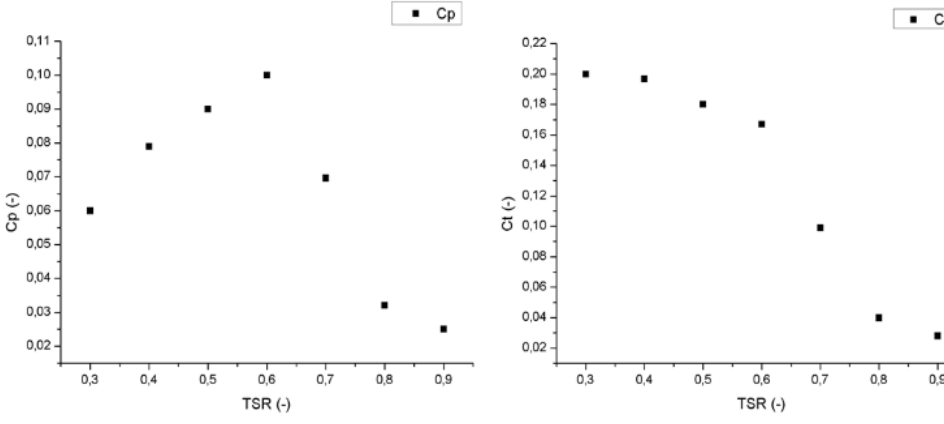
Figure 9: Graph of correlation a) C p with TSR and b) C t with TSR on Rotor Single-Stage.